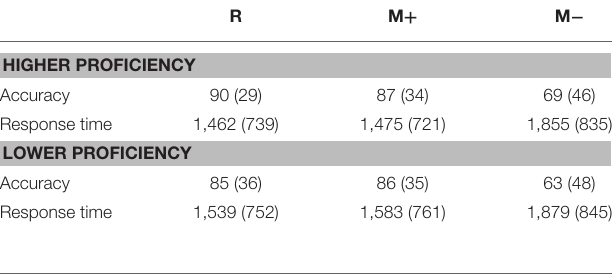
TABLE 4 | Mixed-effects logistic model of accuracy in the semantic relatedness judgment task.